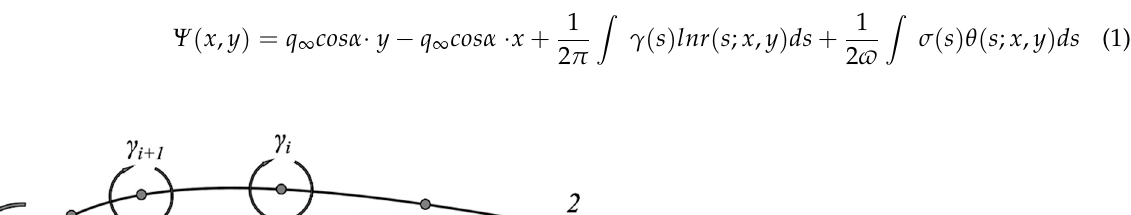
Figure 5. An MH-93 airfoil, as generated by XFOIL from a cloud of points, undeflected (solid line) and with a 20%-chord flap at a 10° deflection (dashed line).